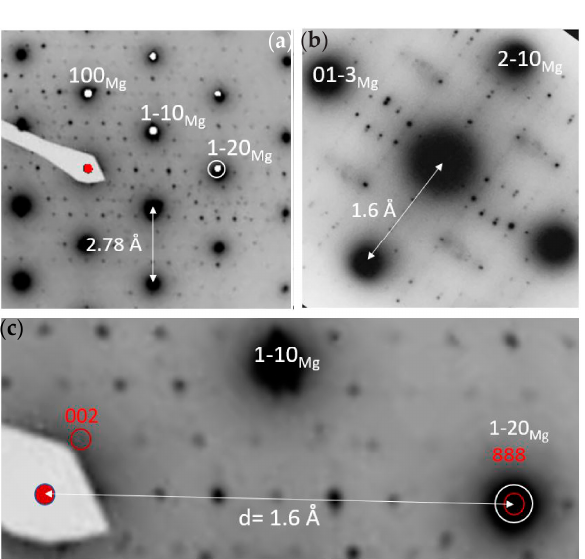
Figure 8. SAD patterns of β precipitate in alloy WE43-T5 showing: ( a ) [001]Mg//[1 − 10] β ZA patterns with corresponding [001]Mg simulation; ( b ) SAD pattern and simulation of the [362]Mg ZA with contributions from plural equivalent orientations of the β precipitates in the Mg matrix; ( c ) (1–20)Mg //(111) β orientation relationship and consistent with face-centered cubic β precipitates with a~ 22 Å cell dimension.